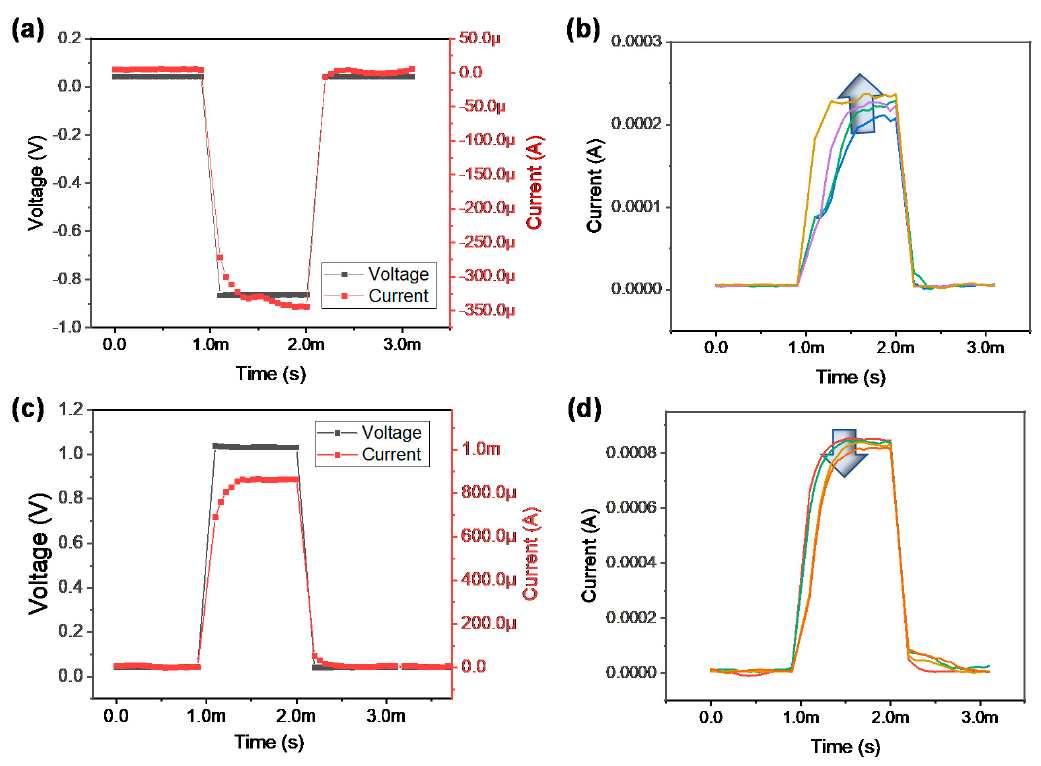
Figure 4. Pulse transient characteristics: ( a ) set process and ( b ) current increase by identical set pulses, ( c ) reset process and ( d ) current decrease by identical reset pulses.